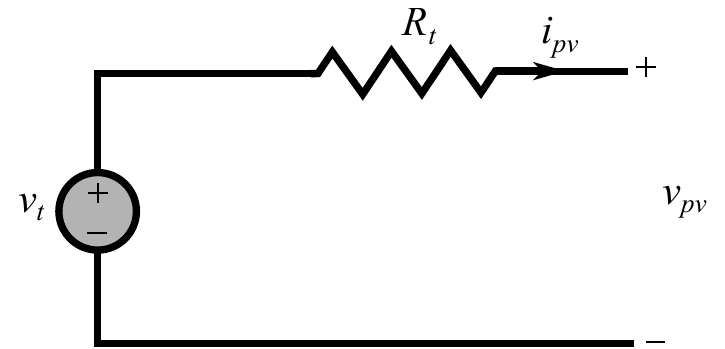
Figure 2. The simplified equivalent circuit of the PV